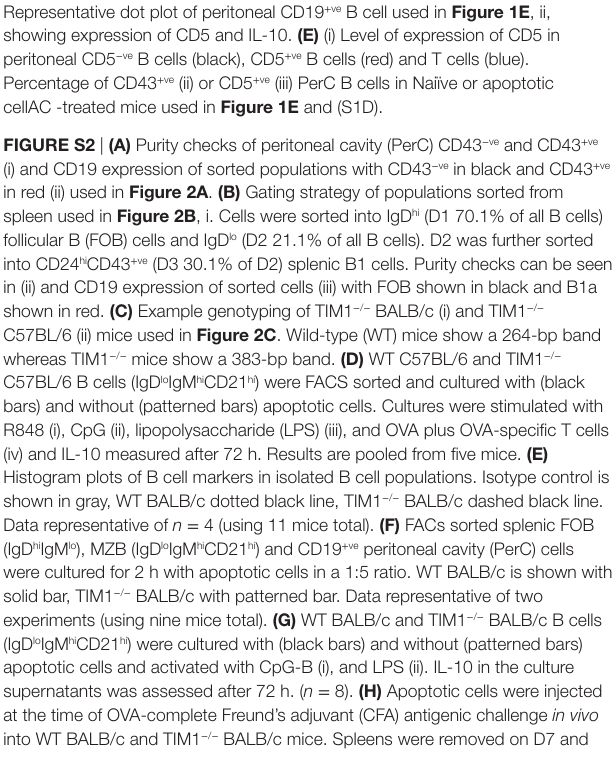
(c) Sorting strategy (i) and purity checks (ii) of splenic IL-10 + ve cells which were further analyzed in Figure 1c . (iii) Percentage of IL-10 + ve splenic CD19 + ve B cells